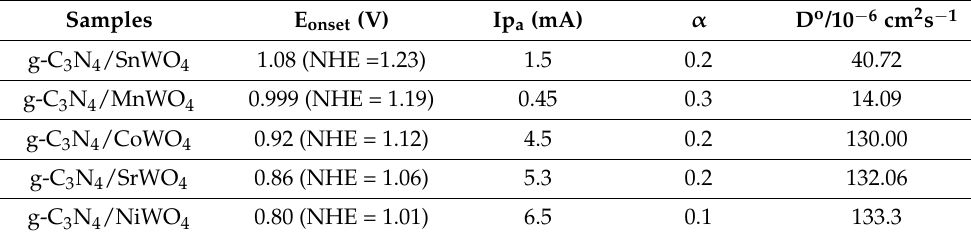
Table 3. Kinetics parameters for water oxidation at g-C 3 N 4 /MetalWO 4